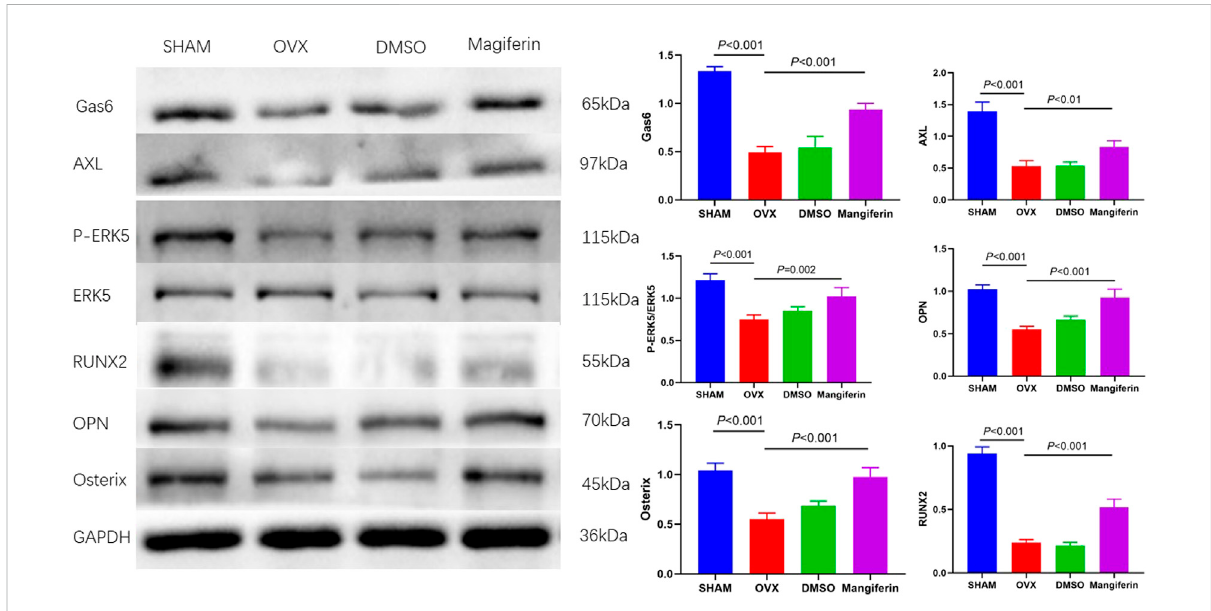
FIGURE 10 Western blot of the femur in the SHAM, OVX, DMSO, and mangiferin group. The protein levels of Gas6, AXL, P-ERK5/ERK5, OPN, Osterix, and RUNX2 signi fi cantly decreased in the OVX and DMSO group (when compared with the SHAM group, p < 0.001, respectively), while they signi fi cantly increased in the mangiferin group (when compared with the OVX and DMSO groups, p < 0.05,